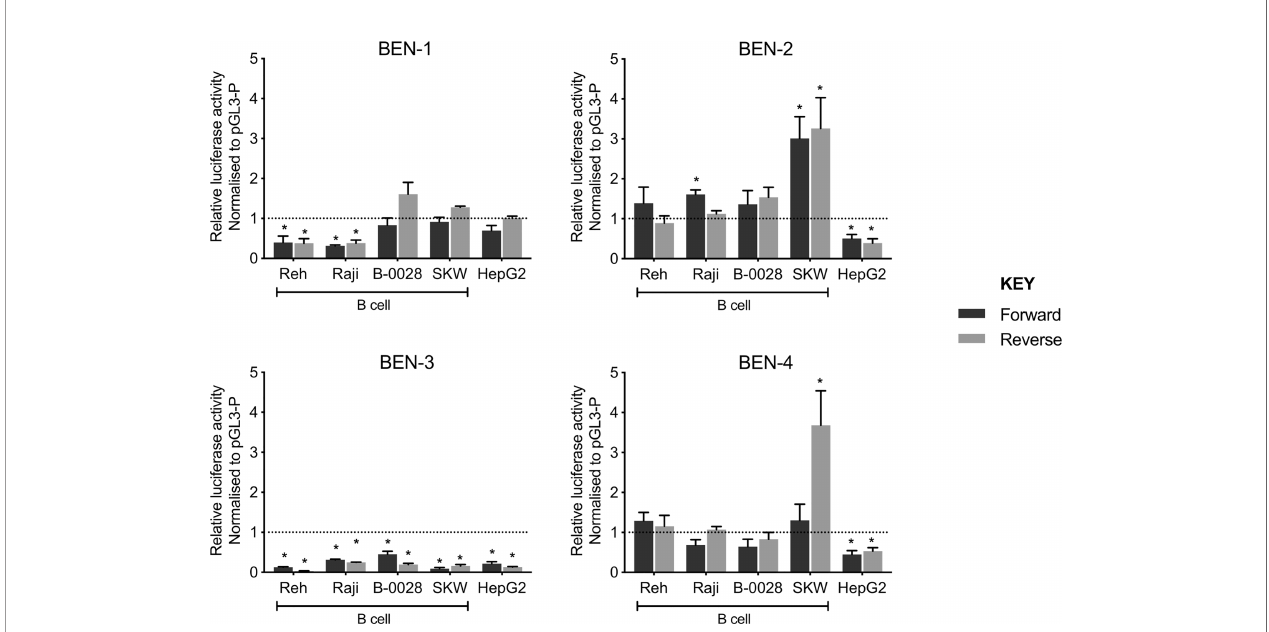
FIGURE 4 | Candidate B cell enhancers demonstrated regulatory potential in luciferase assays, and BEN-2 increased relative transcriptional activity across a panel of B cell lines. Enhancer constructs for strong candidate B cell enhancers were cloned into the pGL3-P (Promega) luciferase plasmid, upstream of an SV40 minimal promoter in forward (black) and reverse (grey) orientation. Bars represent mean relative luciferase activity ± SEM after normalisation to an empty pGL3-P (no enhancer) control plasmid ( n = 3 to 8). Asterisks represent statistically signi fi cant differences between normalised values and the pGL3-P control ( p < 0.05). Dotted line at y = 1 represents normalised pGL3-P control